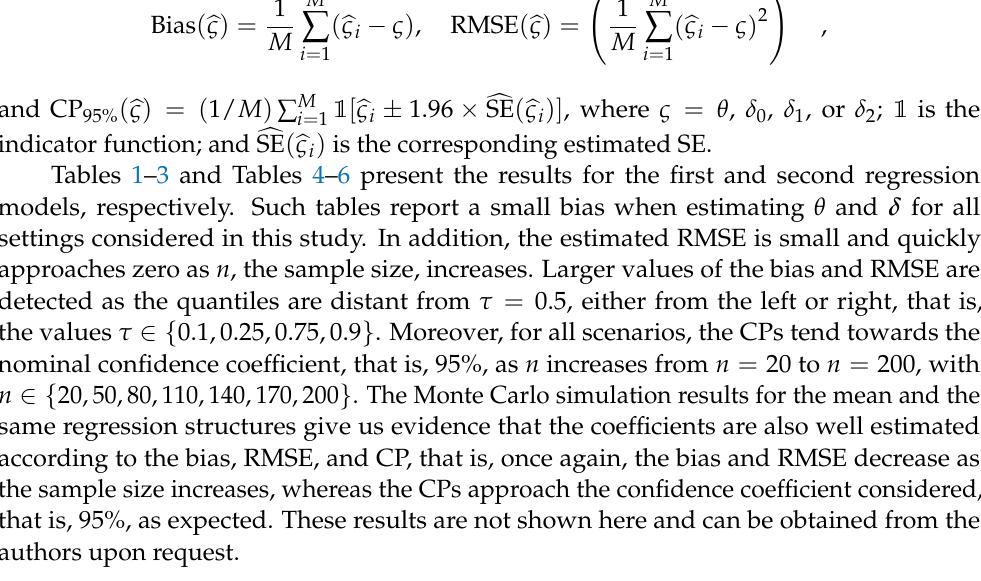
Table 1. Empirical bias, RMSE, and 95% CP (true values: δ 0 = 1.00, δ 1 = 2.00, and θ = 0.25) with simulated